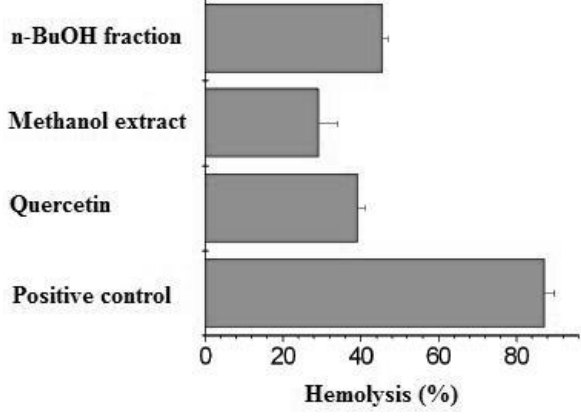
Figure 1. AAPH-induced hemolysis and the protective effect of n -BuoH fraction and methanolic extract of leaves from M. albicans . Concentration: n -BuOH fraction 0.59 mg/mL; methanolic extract 4.3 mg/mL; quercetin 0.08 mg/mL. The reaction mixture